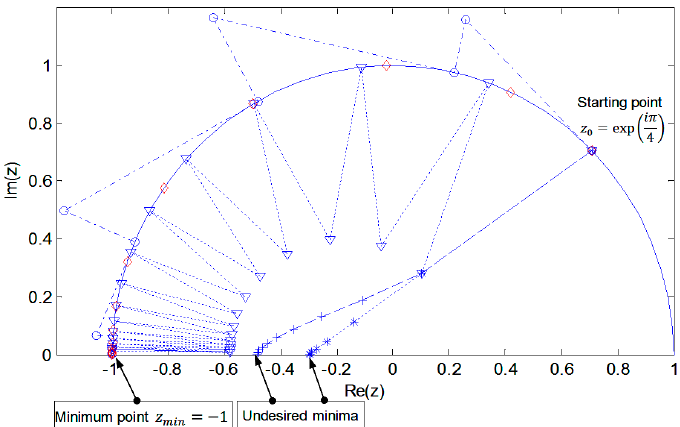
Figure 3. Comparison of SD algorithms for minimizing the cost function on group 𝐔(1) . Methods in the Euclidean versus Riemannian space (Lie group methods). * algorithm SD unconstrained on the Euclidean space (1). algorithm SD on the Euclidean space with penalty function (3). o non-geodesic algorithm SD on Riemannian space (4).